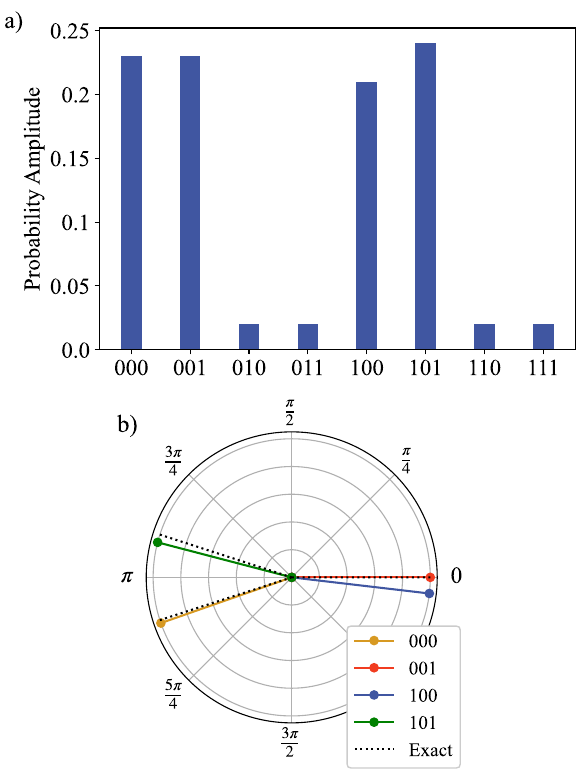
Fig. 10 Eigenvalue Estimation. a Determining the eigenstates overlapped by the initial state: The 3-qubit XY Hamiltonian was diagonalized on a quantum simulator in the subspace of initial state θ γ ψ opt and opt . Here we show the output of 0 j i ¼ 110 j i to obtain measuring W ð θ opt Þ y ψ 0 j i in the computational basis on ibmq_boe- blingen. The 4 non-zero states correspond to the 4 eigenvectors overlapped by ψ 0 j i . b Eigenvalue Estimation using QEE. Here we show the result of implementing QEE (using fsVFF as a pre- processing step) on ibmq_santiago to calculate the eigenvalues of the eigenvectors in the subspace overlapped by 011 j i . The solid yellow, red, blue and green lines represent the eigenvalues obtained eigenvalues are plotted as phases since for Δ t = 1 there is a one to one reduce the algorithmic resources as compared to the previously proposed VFF algorithm. In particular, fsVFF only requires fi nding a diagonalization of a short-time evolution unitary on the subspace spanned by the eigenstates of the Hamiltonian with non-zero overlap with the initial state. When this subspace is much smaller than the total Hilbert space, fsVFF can utilize much simpler ansätze